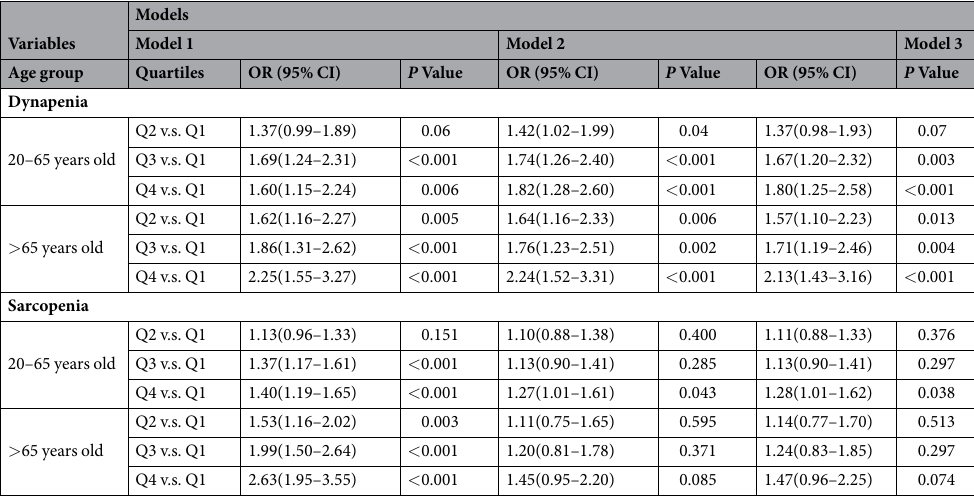
Table 5. Association between the quartiles of serum phosphate and the presence of dynapenia and sarcopenia. Model 1 = Unadjusted. Model 2 = Model 1 + age, sex, race/ethnicity + BMI, serum fasting glucose, serum cholesterol, AST, serum HDL, serum calcium, serum creatinine. Model 3 = Model 2 + history of congestive heart failure, coronary heart disease, angina/angina pectoris, heart attack, stroke,